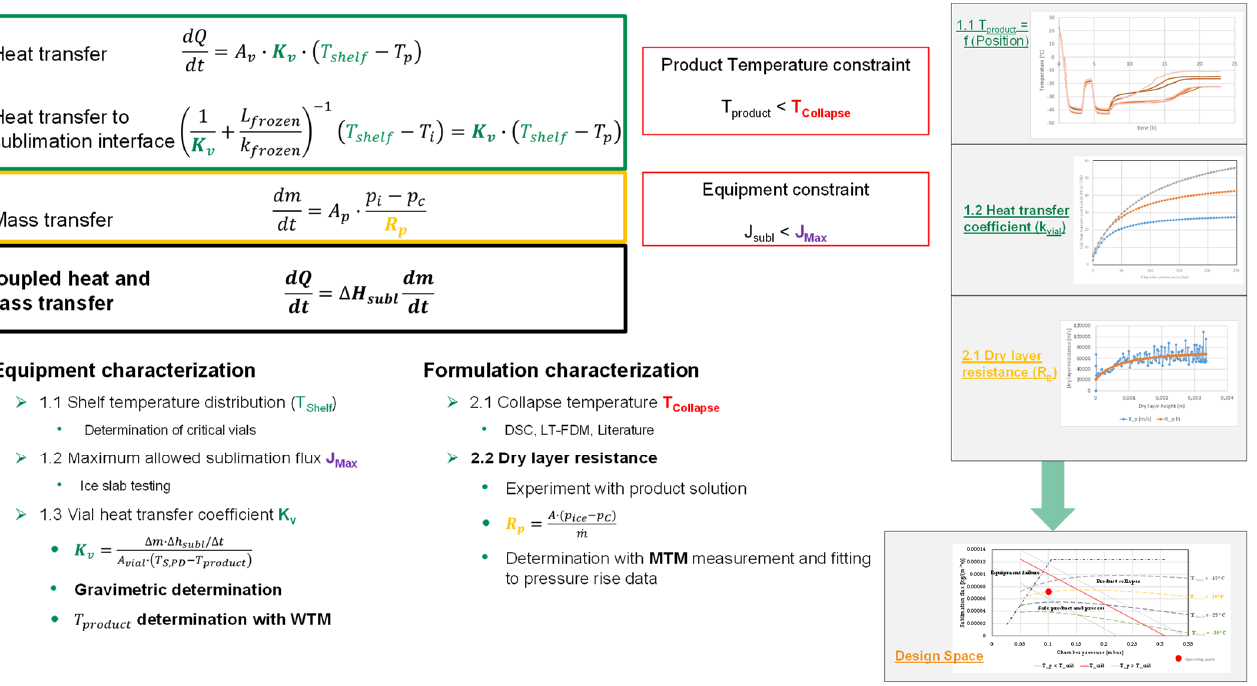
Figure 7. Model parameter determination concept.